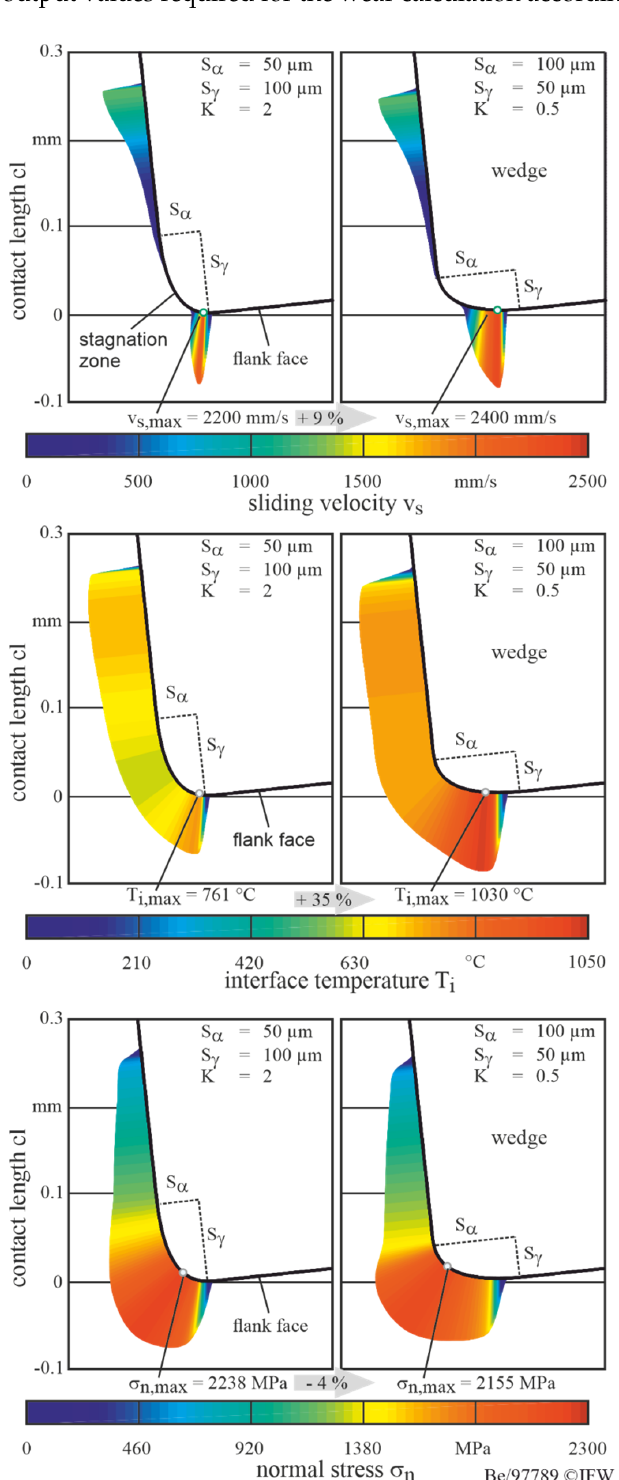
Figure 11. Effect of asymmetric rounded cutting edges on the thermomechanical and kinematic load during machining of